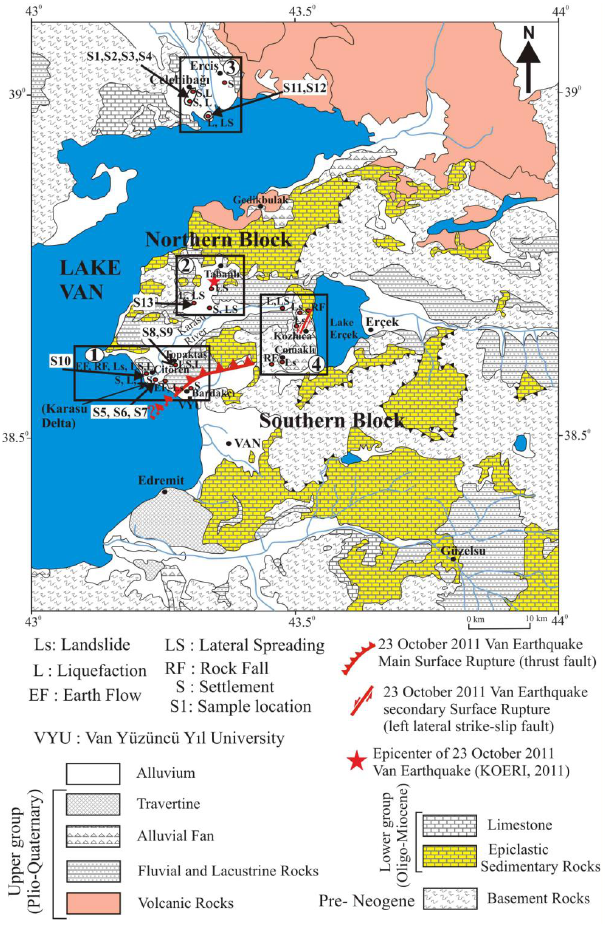
Fig. 2. Geology map of the Van region (MRE, 2002) and geograph- Figure 2. Geology map of the Van region (MRE, 2002) and geographical distribution of mass 3 ical distribution of mass movements and liquefaction features along movements and liquefaction features along with the main and secondary surface ruptures 4 with the main and secondary surface ruptures that occurred during occurred during the 23 October 2011 Van earthquake. 5 the 23 October 2011 Van